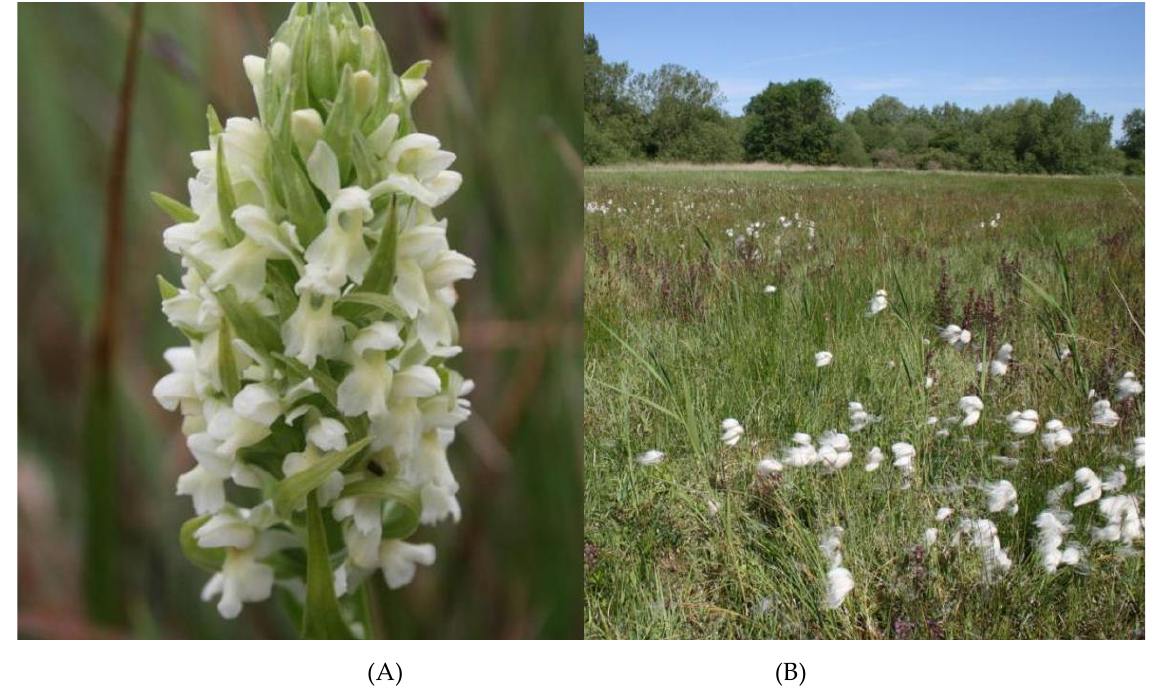
Figure 1. East Anglia site where the last viable population in England exists. ( A )- Flowering Dactylorhiza incarnata subsp. ochroleuca ; ( B )- Fen habitat.